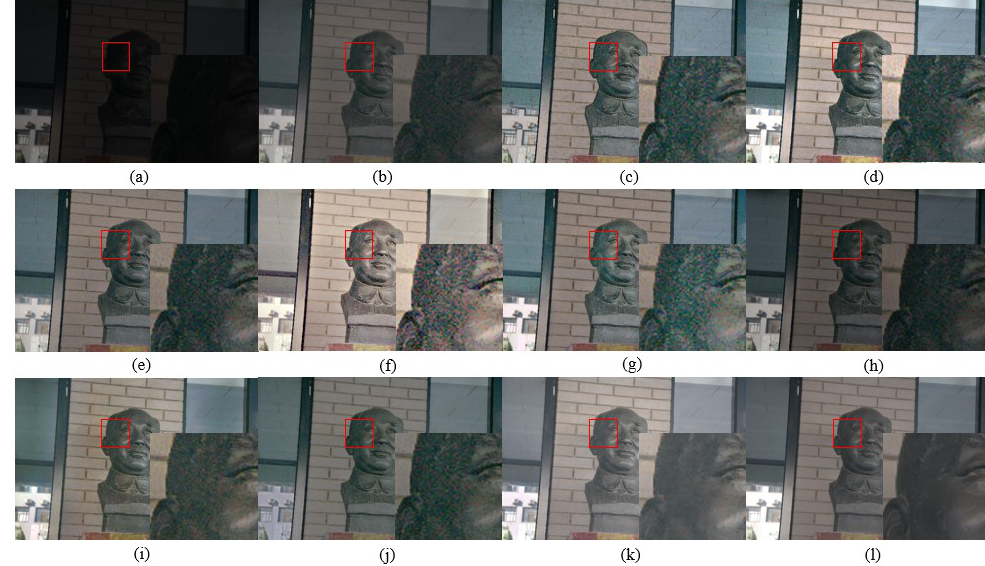
Figure 7. Visual comparison results of different methods on the LOL dataset. ( a ) Input. ( b ) BIMEF. ( c ) Dong. ( d ) LIME. ( e ) MF. ( f ) MultiscaleRetinex. ( g ) NPE. ( h ) SRIE. ( i ) EnlightGAN. ( j ) Zero-DCE. ( k ) Ours. ( l ) Ground Truth.